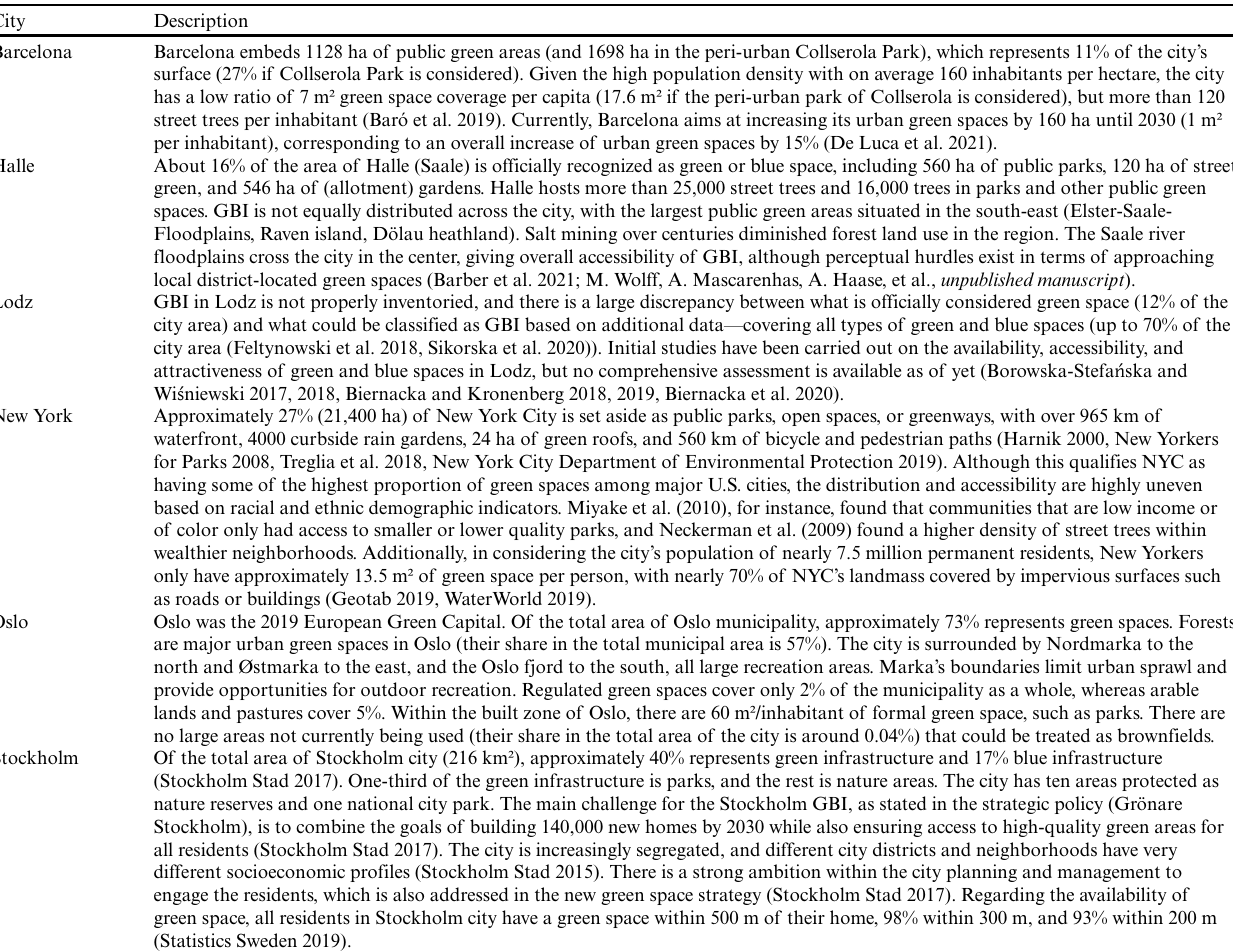
Table 2. Basic information on GBI and GBI availability, accessibility, attractiveness in the case-study cities—with references to some illustrative